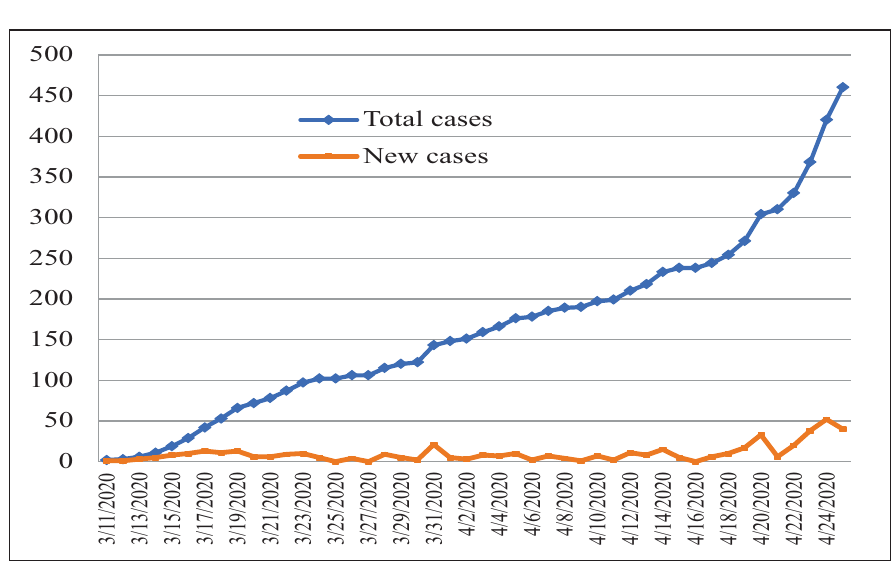
Figure 1: Total and new COVID-19 patients reported from 11 March to 26 April